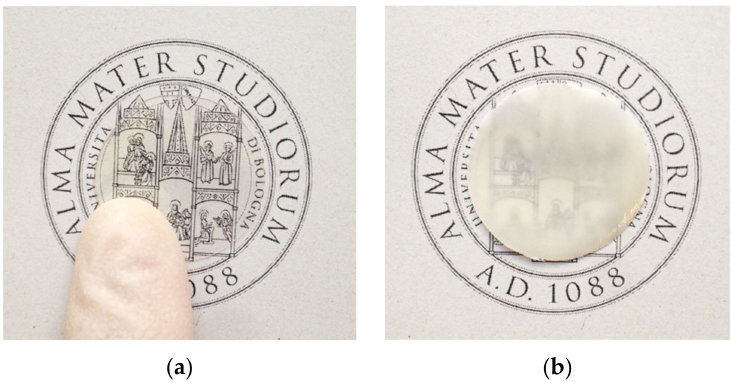
Figure 3. Membrane samples used for permeation tests. ( a ) PPO and ( b ) 25 wt% ZIF-8 /